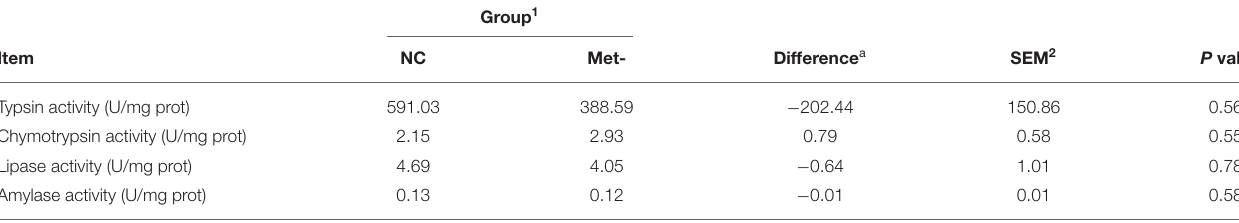
TABLE 3 | Effects of Met deficiency in rearing period diets on digestive enzymes activities in duodenum of egg-laying chicks at 6 weeks.